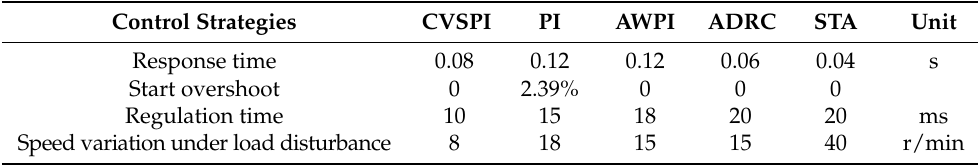
Table 5. Comparison of performance with a load of 15 N · m at rated speed and a sudden load relief of 5 N · m at 0.2 s. Control Strategies CVSPI PI AWPI